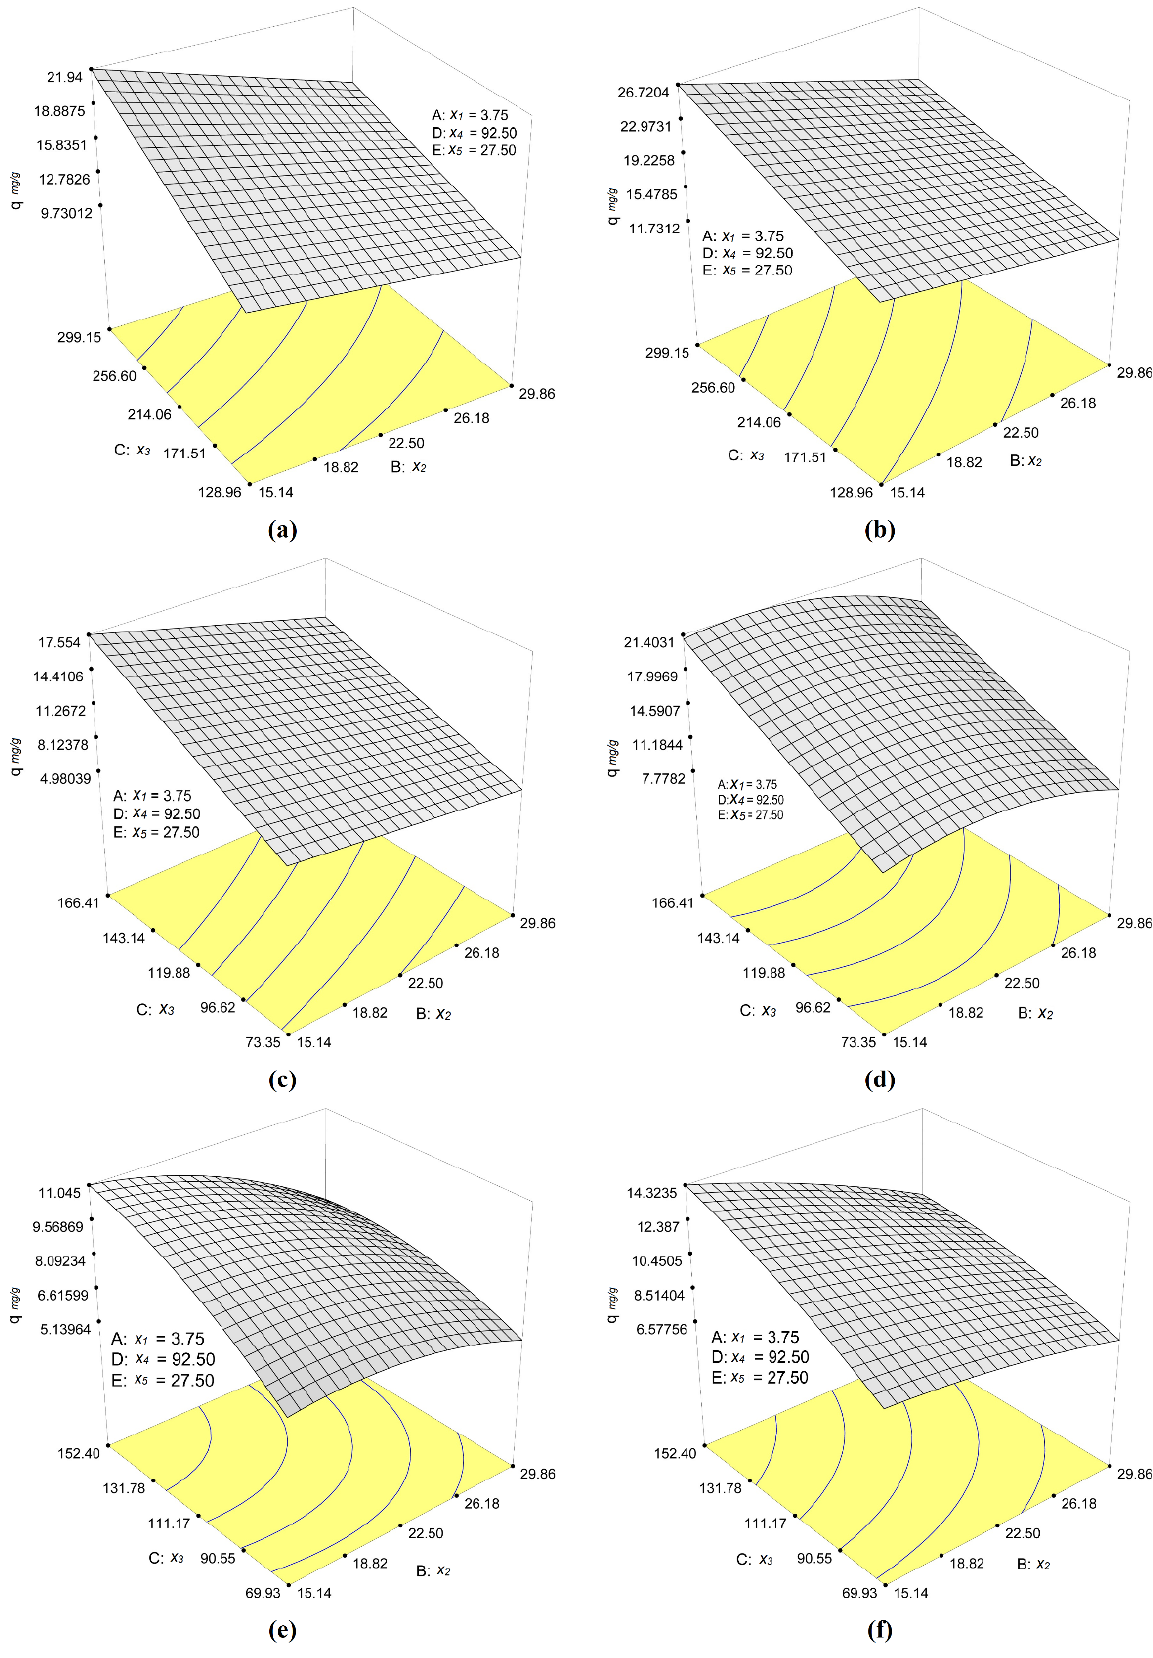
Figure 14. Response surfaces for mathematical models developed for biosorption capacity of metal ions ( q , mg/g) (the meaning of the notations ( a – f ) is the same as those from Figure 9).